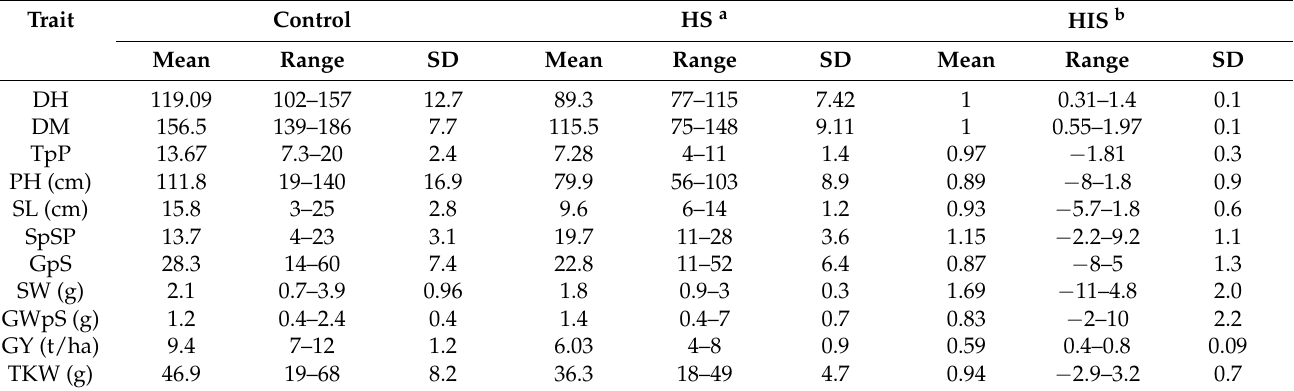
Table 1. Descriptive statistics of synthetic hexaploid wheat under control and HS